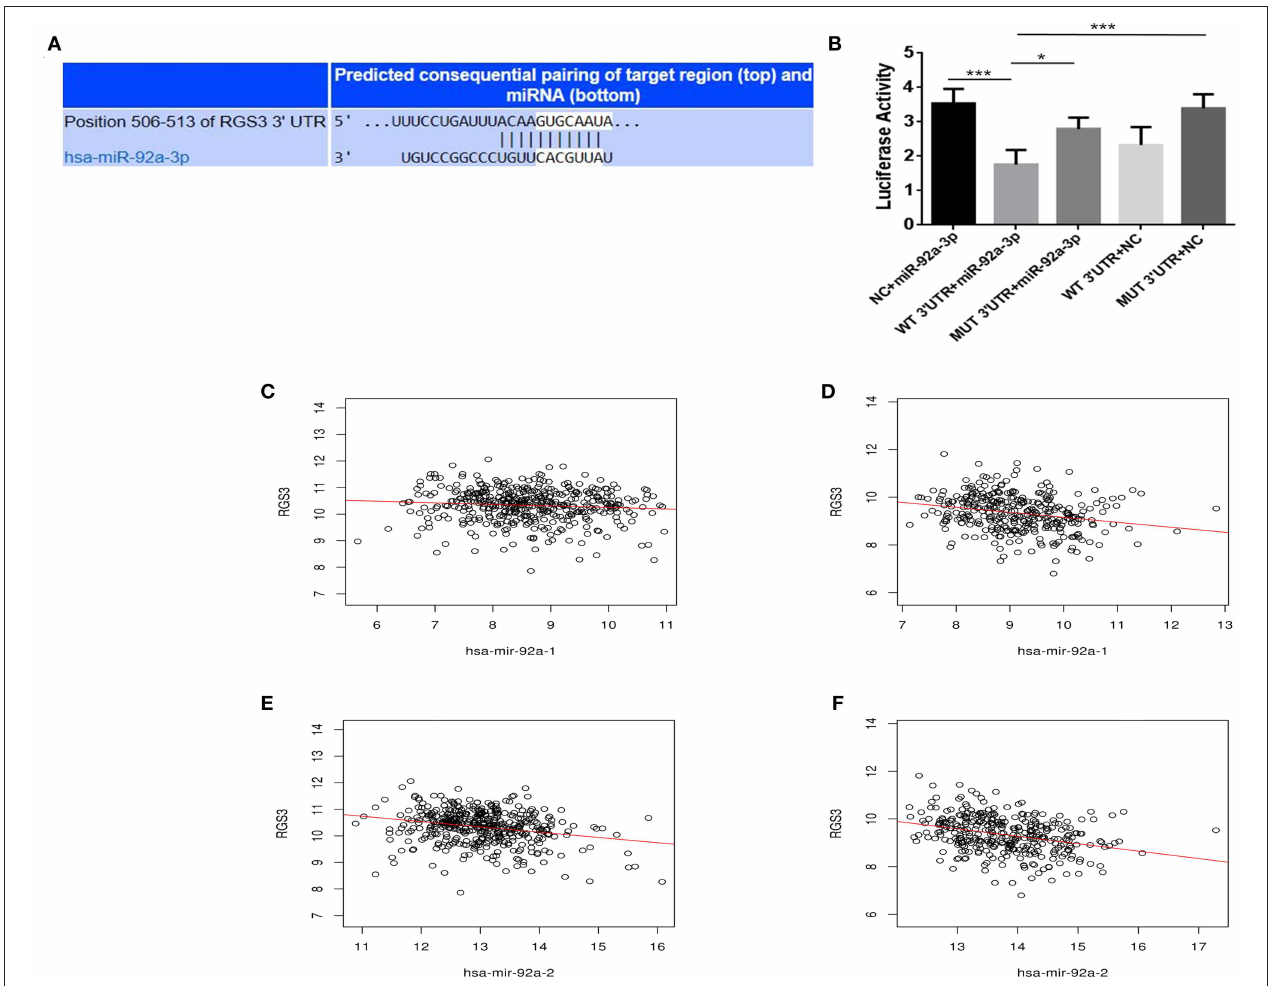
FIGURE 5 | RGS3 is targeted by miR-92a. (A) Putative binding sites in the RGS3 3’UTR for miR-92a by starbase. (B) miR-92a targets the RGS3 3’-UTR. Luciferase activity of the RGS3 reporter with a wild or mutated miR-92a binding site was measured at 48h post-transcription with miR-92a mimics or negative control, * p < 0.05, *** p < 0.001, Dunnett- t -test. (C–F) Expression of miR-92a was negatively correlated with the level of RGS3 in NSCLC from TCGA, r value and p -value were determined using spearman correlation